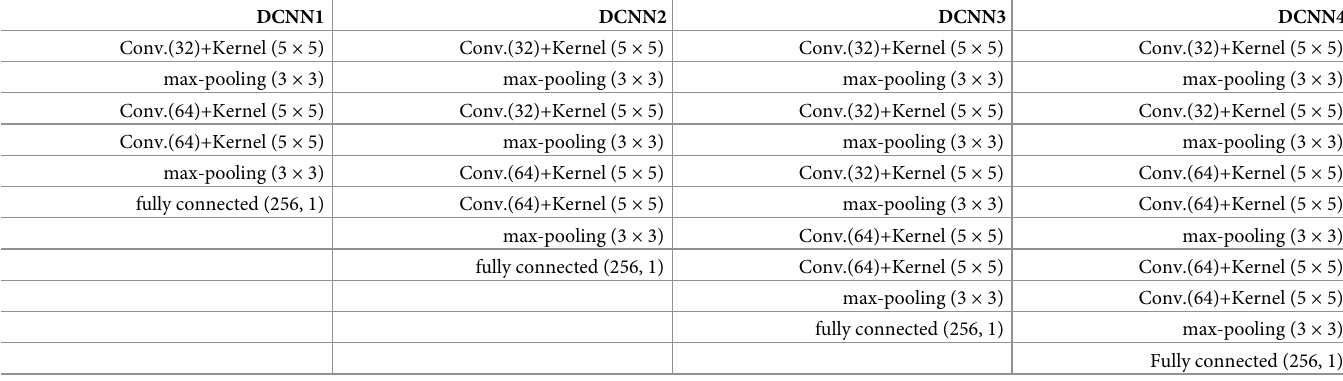
Table 1. Core structure of the proposed deep CNN